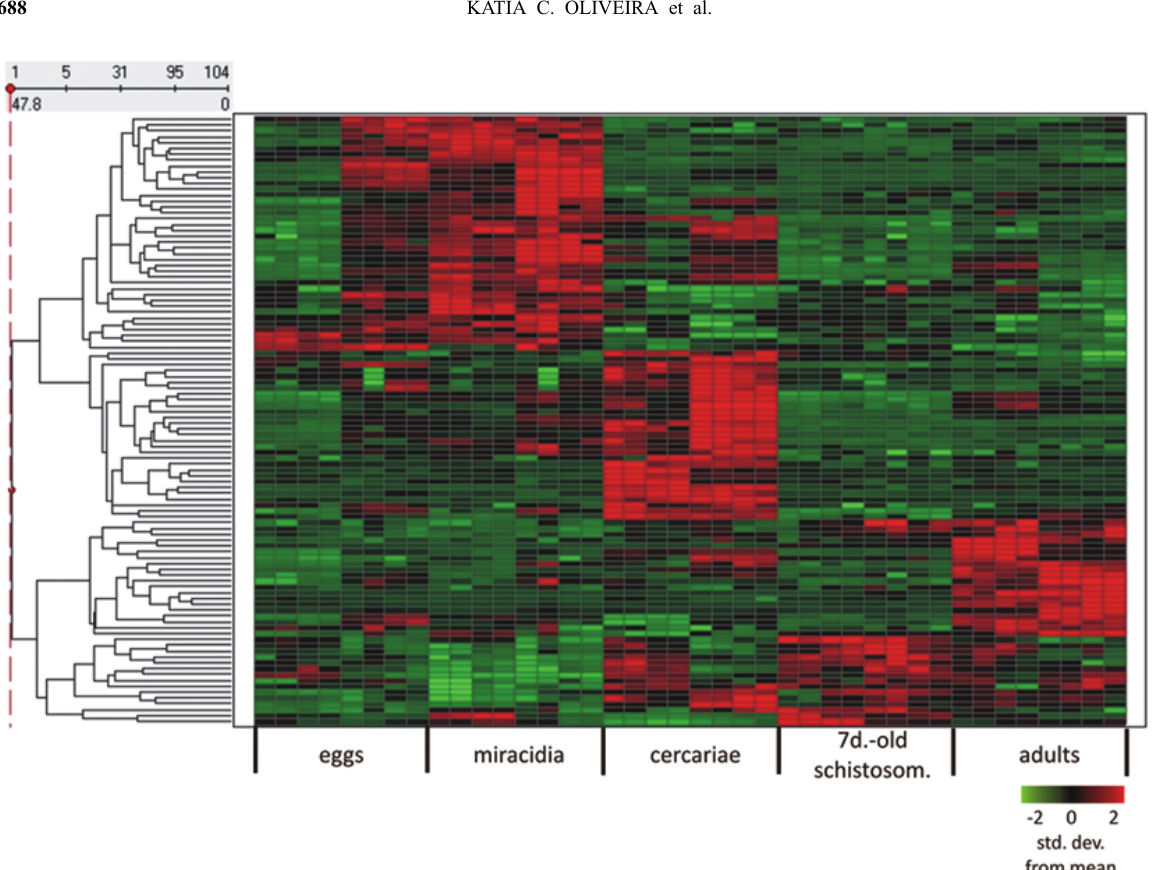
Fig. 5 – Heat map of differential expression of non-protein coding genes among 5 developmental stages. Each line represents a gene and each column represents a replica (4 technical replicas for each one of two biological replicas). Color is proportional to expression levels of the gene in a given stage, according to the range shown in the figure insert, and indicates the number of standard deviations below (green) or above (red) the average expression of that gene across all